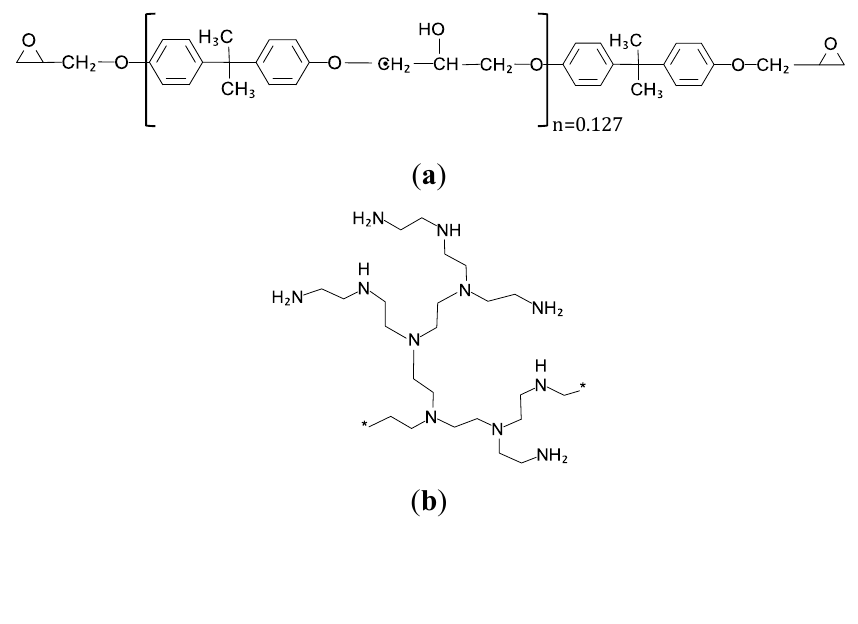
Figure 1. Chemical structures of ( a ) diglycidyl ether of bisphenol-A (DGEBA) and ( b ) a hyperbranched